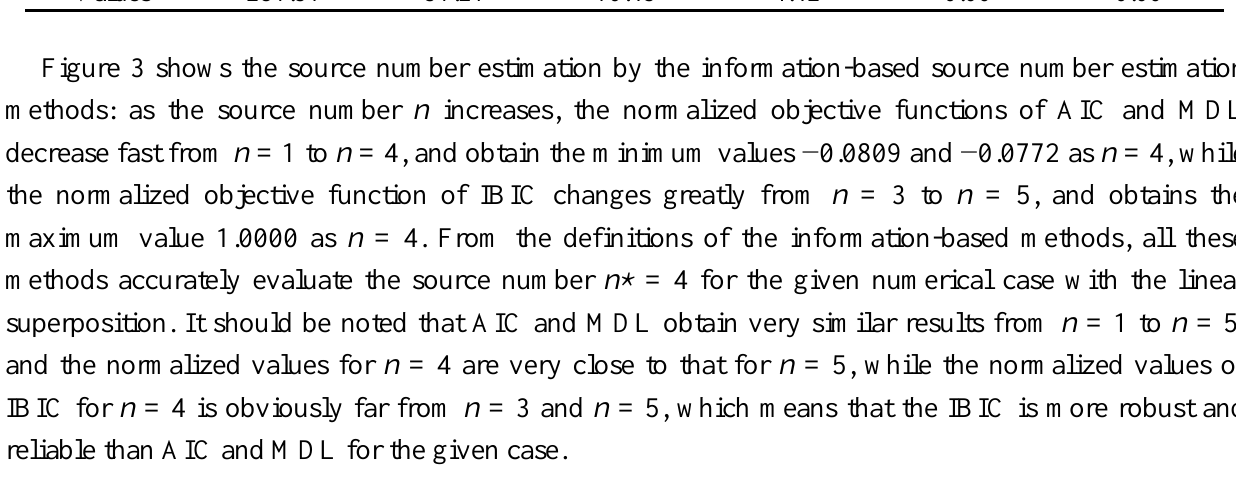
Figure 3. Source number estimation by information-based